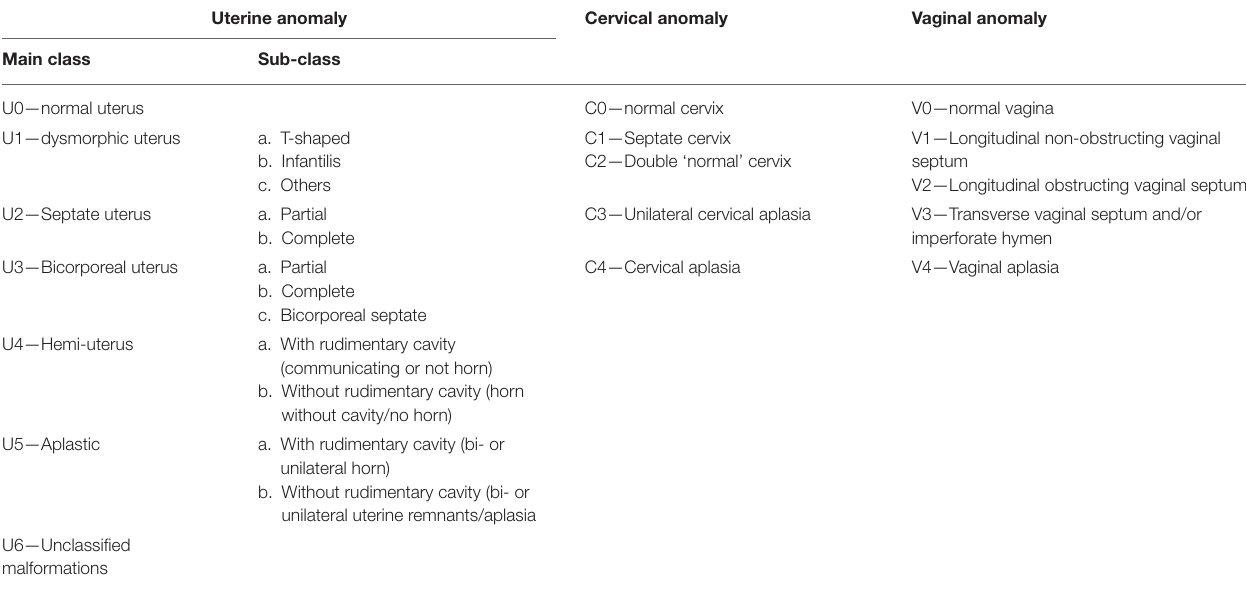
TABLE 1 | Classification of female genital tract anomalies according to the European Society of Human Reproduction and Embryology (ESHRE) and European Society of Gynecological Endoscopy (ESGE). Uterine anomaly